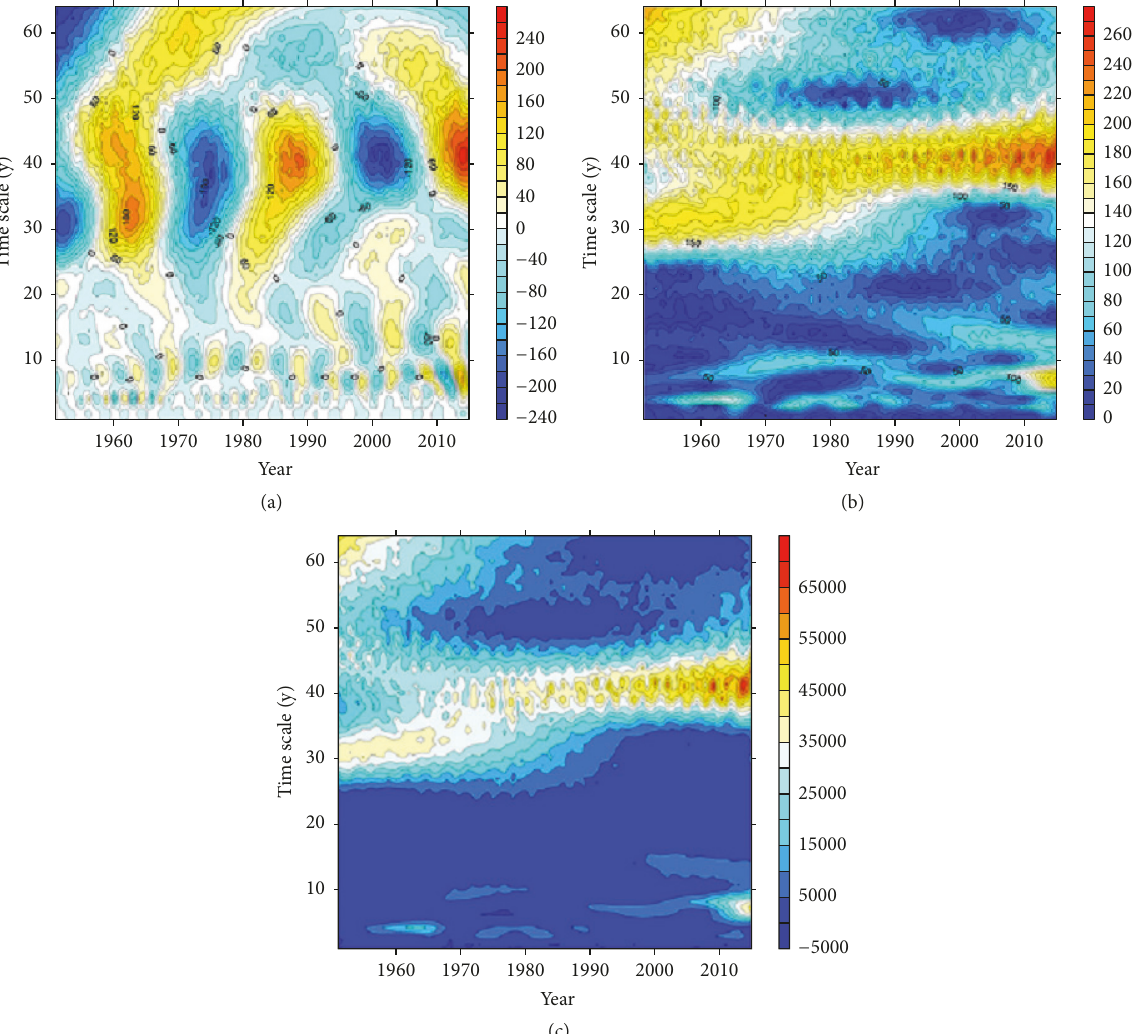
Figure 3: The real part, modulus, and the second power of the modulus of the wavelet coefficient contour of precipitation: (a) real part wavelet coefficient contour map of precipitation; (b) modulus of wavelet coefficient contour map of precipitation; (c) the second power of the modulus of the wavelet coefficient contour map of precipitation.